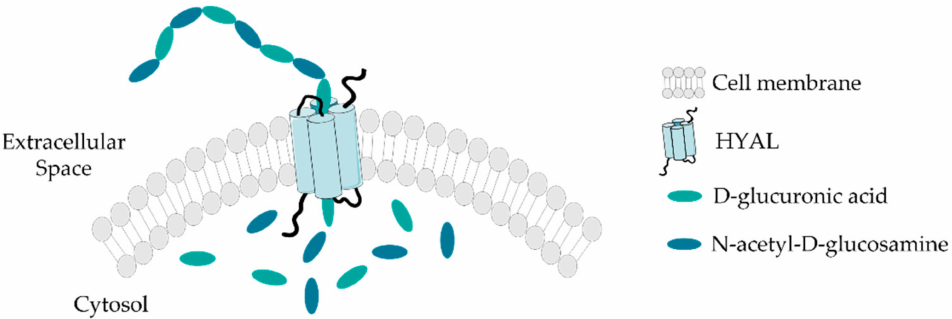
Figure 2. Schematic representation of the synthesis of HA by hyaluronan synthases (HAS-1, HAS-2 and HAS-3) where the placement of HA in the extracellular space is